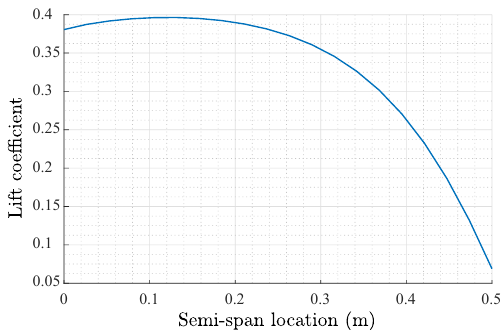
Figure 4. Lift distribution along the